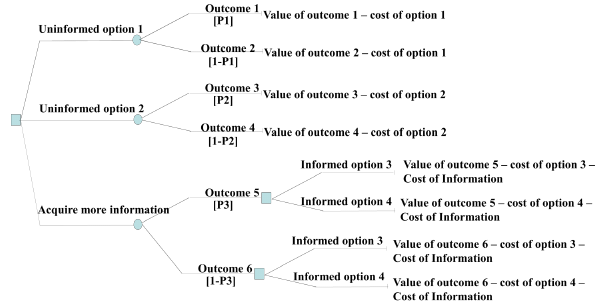
Figure 1 Fig. 1. Example decision tree with three alternatives yielding six potential outcomes with probabilities P1, P2, P3, and complements 1-P1, 1-P2, and